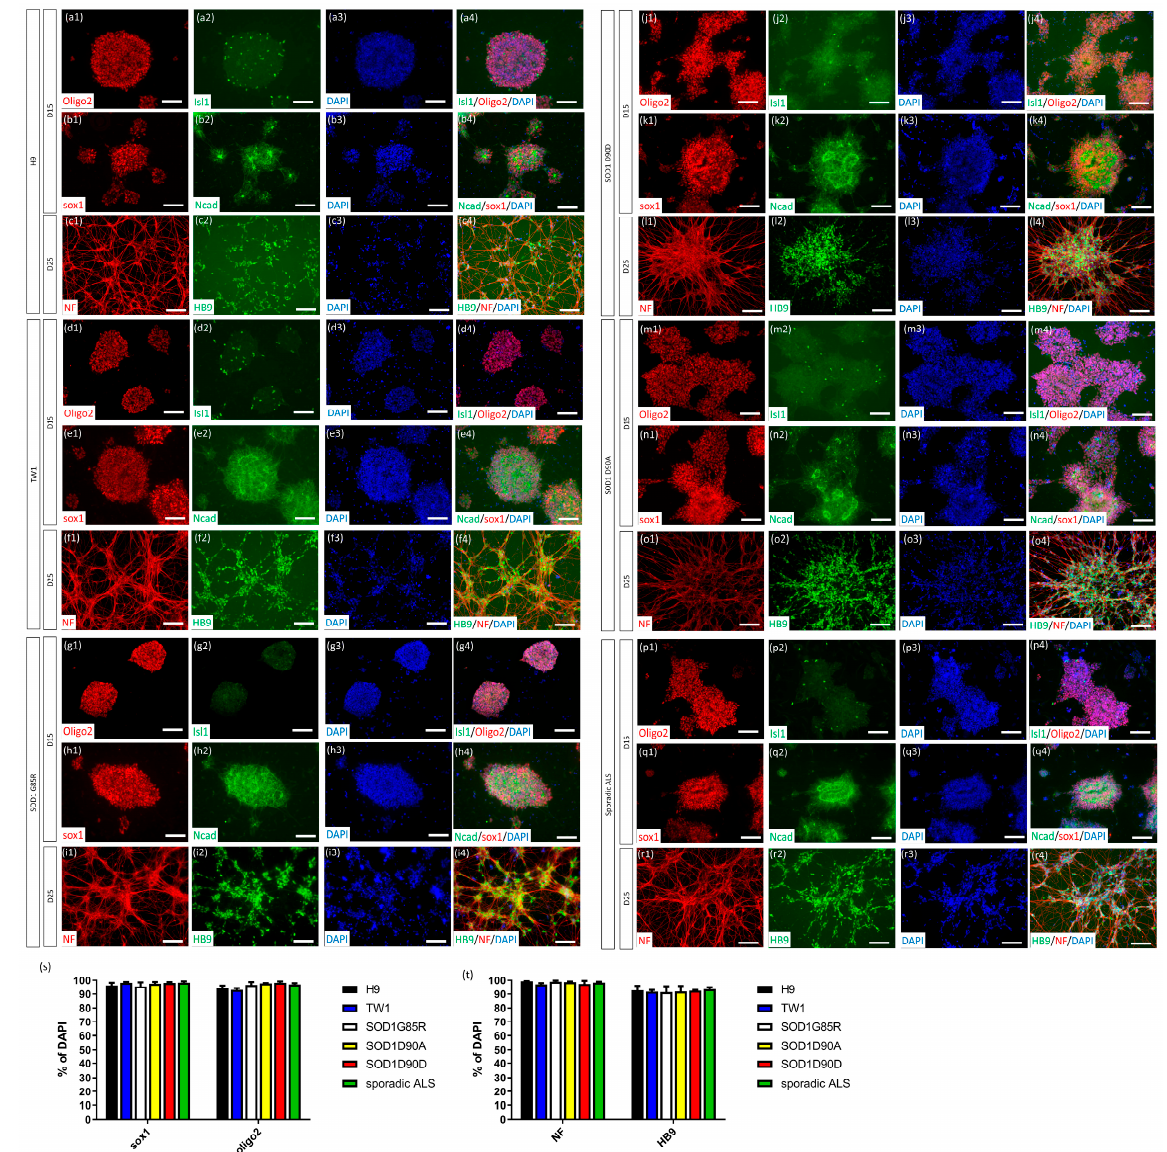
Figure 2. Robust generation of MNs from PSCs using the CHSF-MN protocol. Identification of hESC lines, including H9 ( a – c ), TW1 ( d – f ), and iPSC lines, such as SOD1 G85R ( g – i ), SOD1 D90D ( j – l ), SOD1 D90A ( m – o ), and sporadic ALS ( p – r )-derived MNPs and MNs, via the CHSF-MN protocol using neural stem cell (Sox1 and N-cadherin) and MNP (Oligo2 and Islet1) markers on day 15 and MN (HB9) and neuronal (NF) markers on day 25 of differentiation. ( s – t ) Calculation of the marker expression ratio of DAPI + cells on days 15 ( s ) and 25 ( t ) of differentiation. Number 1 − 3 presenting the separated images and number 4 presenting merged images in (a − r). Scale bar, 100 μ m.